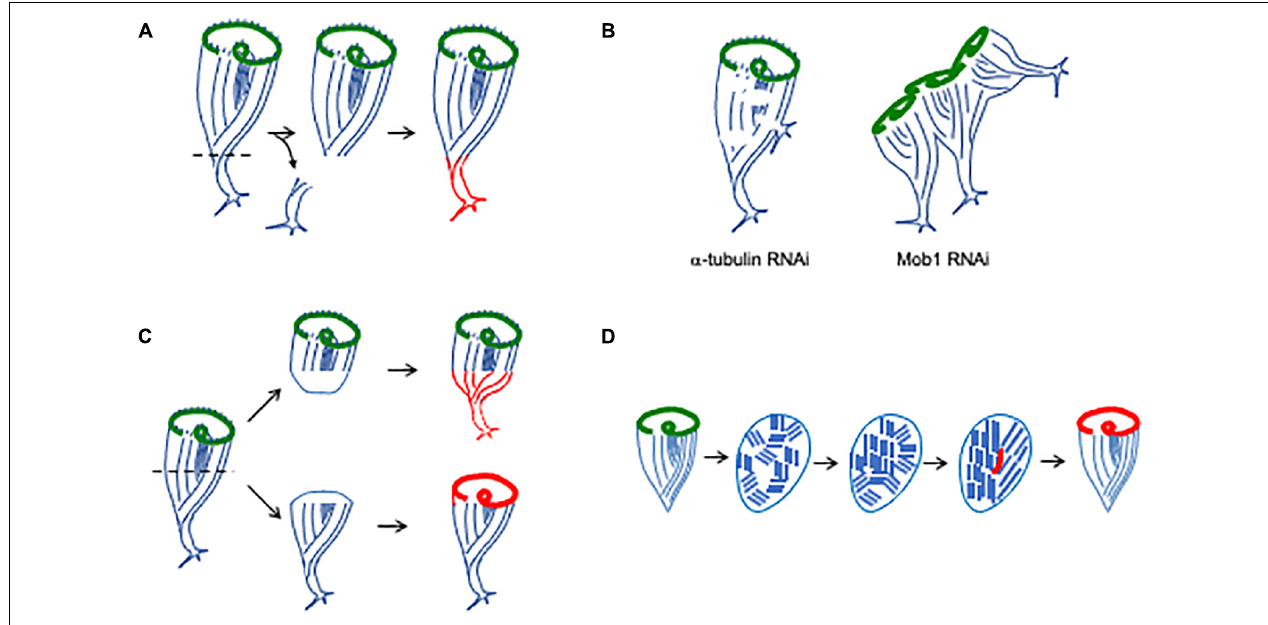
FIGURE 5 | Regenerating and maintaining proper cell shape. (A) Regeneration of holdfast. Newly formed structures are indicated in red. (B) Identification of molecules involved in maintaining a single unified anterior-posterior axis (Slabodnick et al., 2014). Tubulin knockdown causes the ciliary rows to become discontinuous, and additional holdfasts begin to sprout from the sides of the cell body. Mob1 RNAi causes cells to form multiple holdfasts and a garland-like arrangement of oral apparatus, one for each posterior pole. (C) Regeneration of bisected cells. Anterior fragment inherits the pre-existing OA and regenerates a holdfast. Posterior fragment inherits the pre-existing holdfast and regenerates an OA. Note that the half-cells start out with abnormally short and squat shapes, and the anterior fragment has a disproportionately large OA. Properly proportioned shape and sizes of components is gradually established over a period of hours (Morgan, 1901). (D) Regeneration following cortical disarrangement. When cells are minced into pieces, the cortical rows break up into fragments. Over time, these fragments merge, either by growth or rotation, eventually restoring parallel rows. When a region of stripe contrast emerges, an oral primordium (red) forms, leading to formation of a new oral